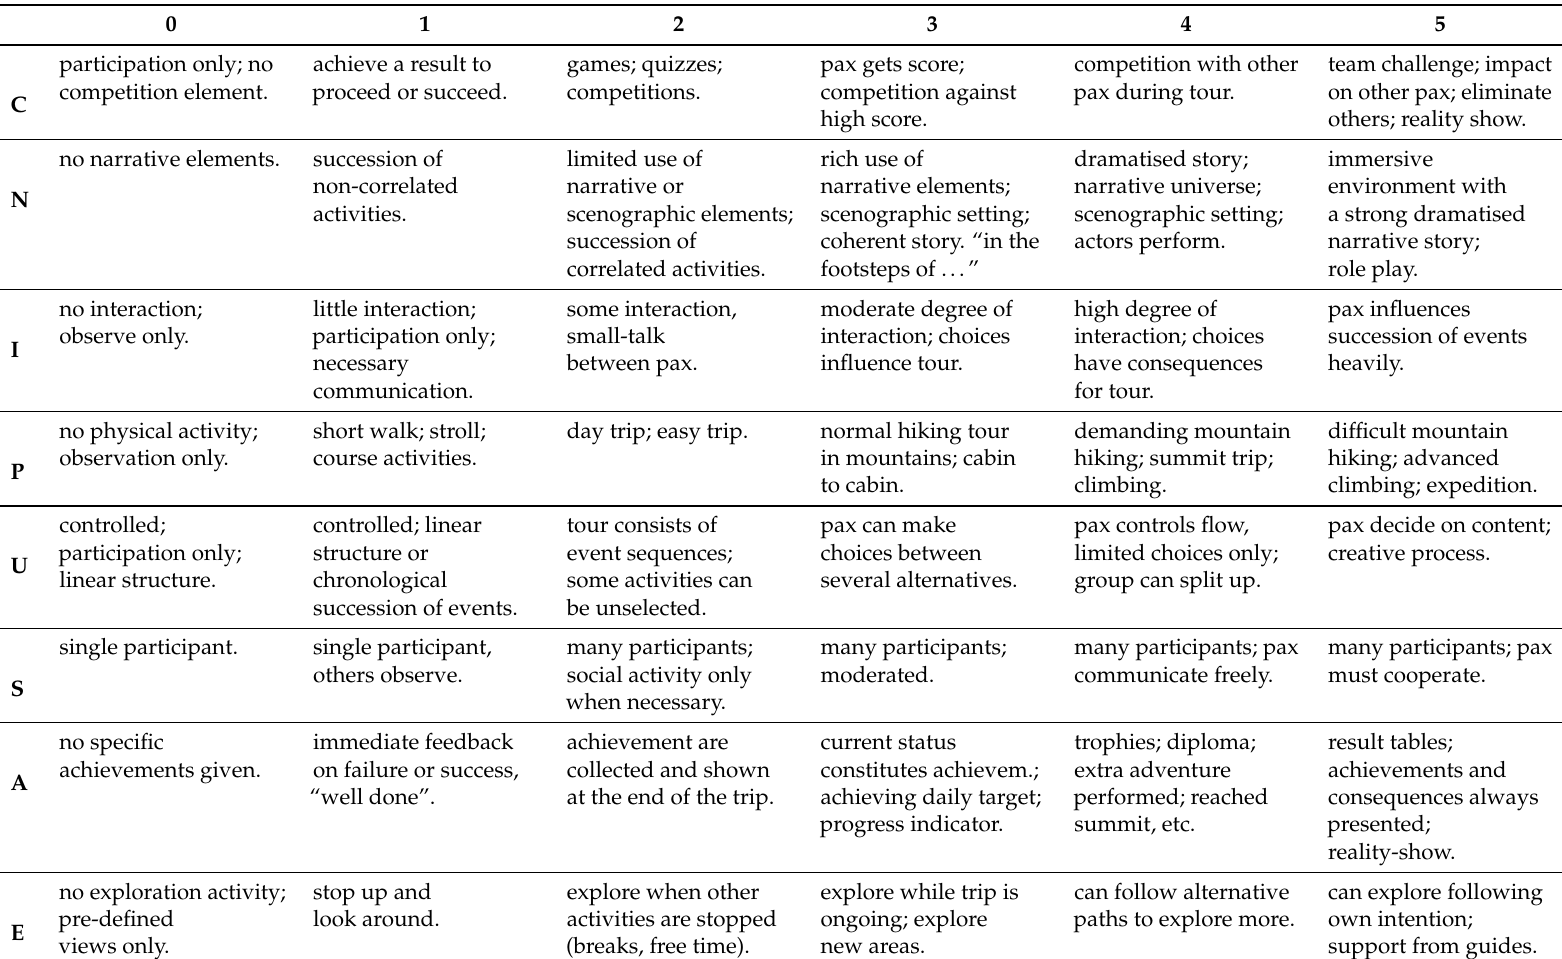
Table 1. Explanation of the values used in the Trekking Engagement Profile, from participant’s viewpoint (not: guides’ viewpoint). The letters in the left column represent competition (C), narrative elements (N), interaction (I), physical activity (P), visitor (user) control (U), social aspects (S), achievements awareness (A), and exploration possibilities (E),